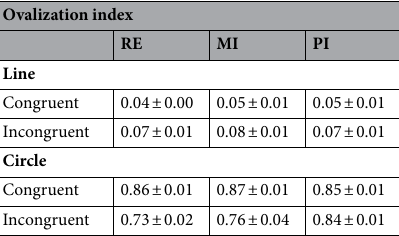
Table 1. Mean values and standard error of the ovalization indexes of lines and circles in Real (RE), Motor Imagery (MI) and Proprioceptive Illusion (PI) protocols and in Congruent and Incongruent